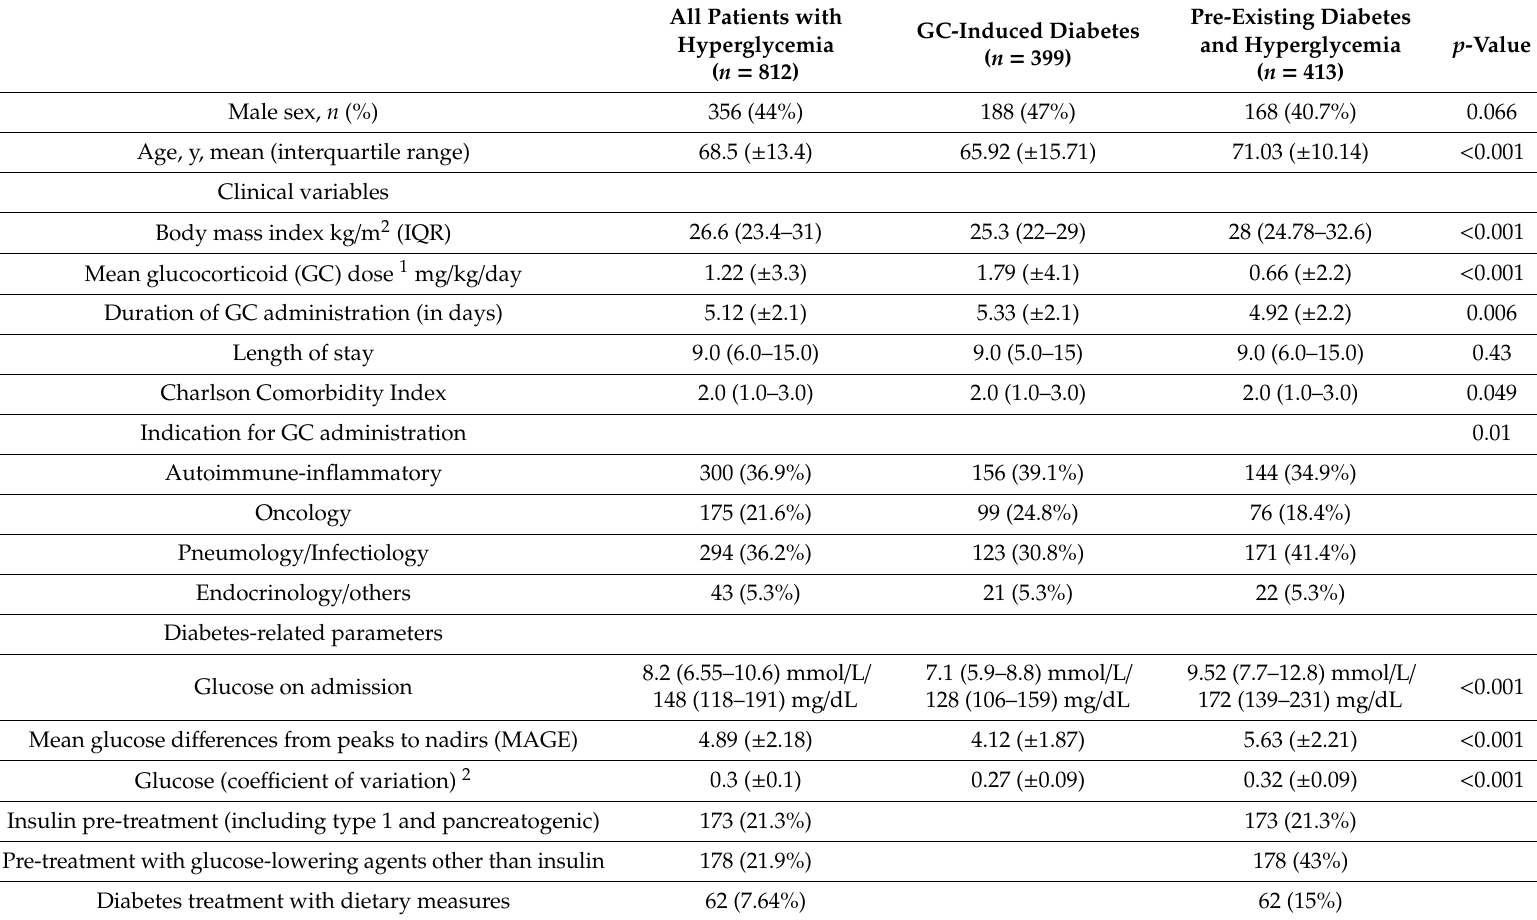
Table A2. Baseline characteristics of patients with pre-existing diabetes vs. GC-induced